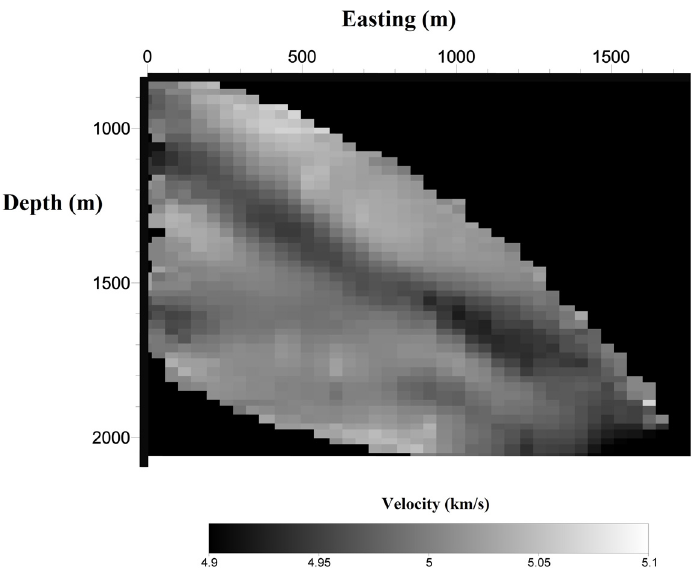
Figure 11. Tomogram showing the checkerboard velocity model using all the events and receivers at a northing slice of − 290